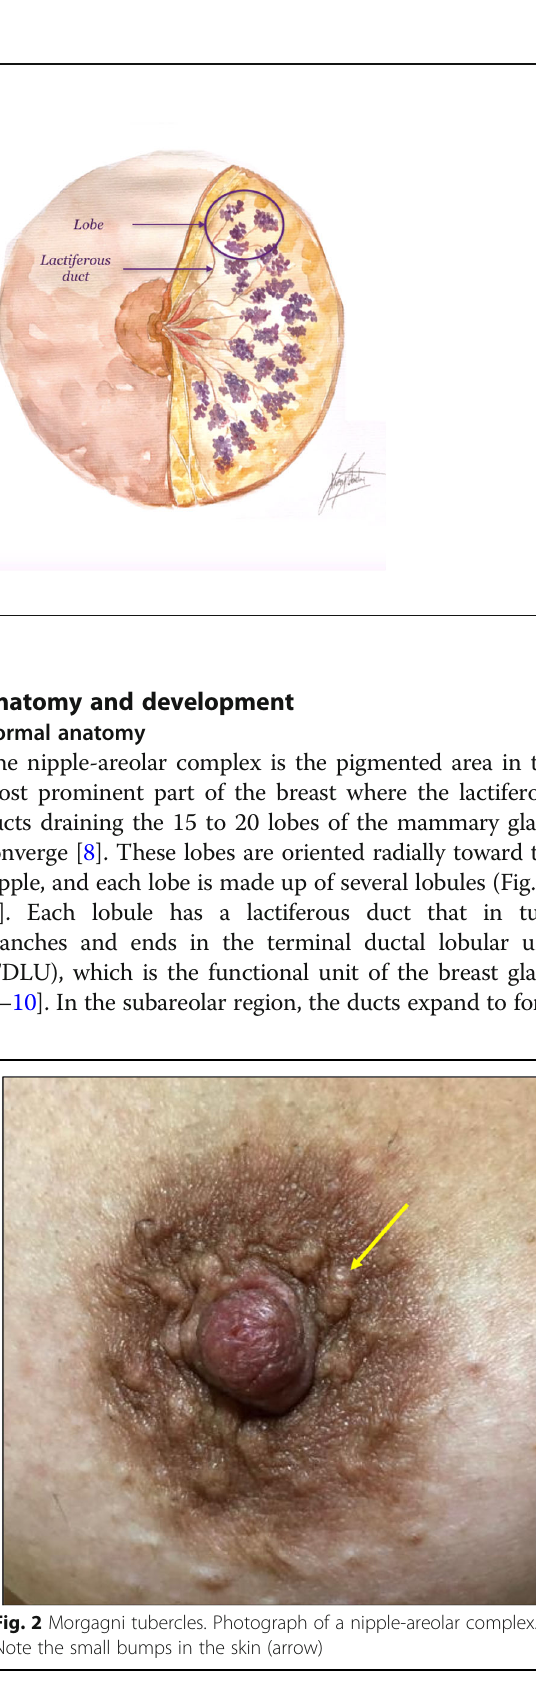
Fig. 2 Morgagni tubercles. Photograph of a nipple-areolar complex. Note the small bumps in the skin